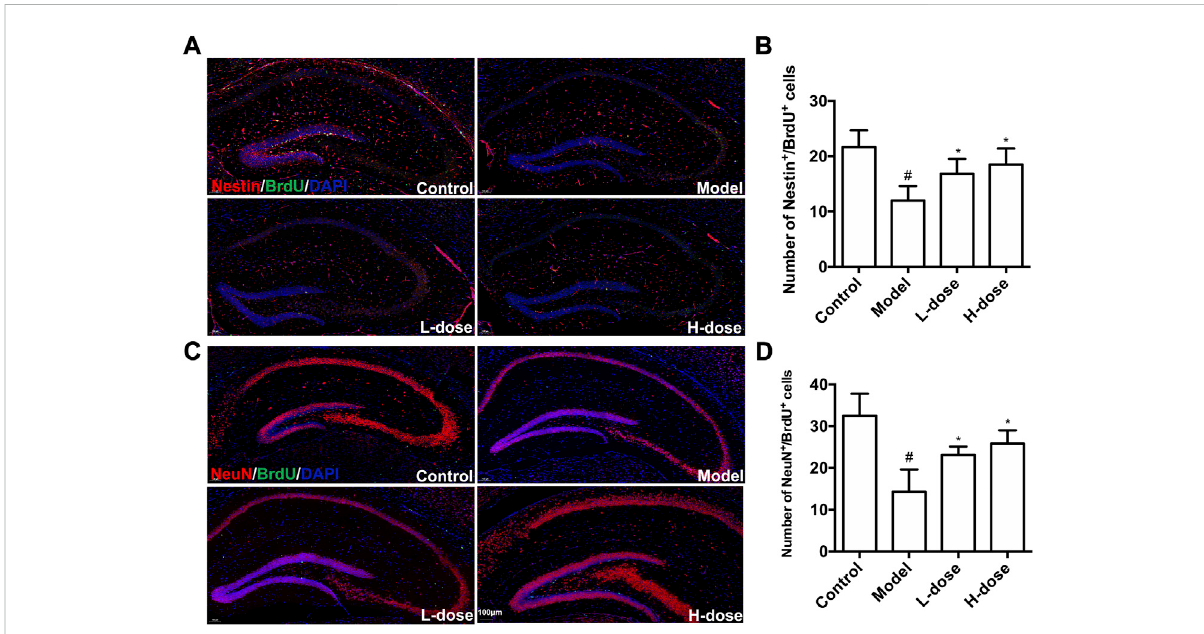
FIGURE 3 BLWE enhanced endogenous NSCs proliferation and differentiates into neurons in APP/PS1 mice. Mice were treated with different dose of BLWE or deionized water for 6 weeks and were injected with BrdU twice a day to label proliferative cells. Proliferating NSCs were labeled with antibodies against Nestin (red) and BrdU (green), respectively (A) . ImageJ software counted Nestin/BrdU positive cells in each group (B) . Newborn neuronswerelabeledwithantibodiesagainstNeuN(red)andBrdU(green),respectively (C) .ImageJsoftwarecountedNeuN/BrdUpositivecells in each group (D) . The nucleus is counterstained with DAPI (blue). Scale bar = 100 μ m in A and C. # p < 0.05 vs. the control group; * p < 0.05 vs. the model group. Values are expressed as the mean ± SD ( n = 6 per